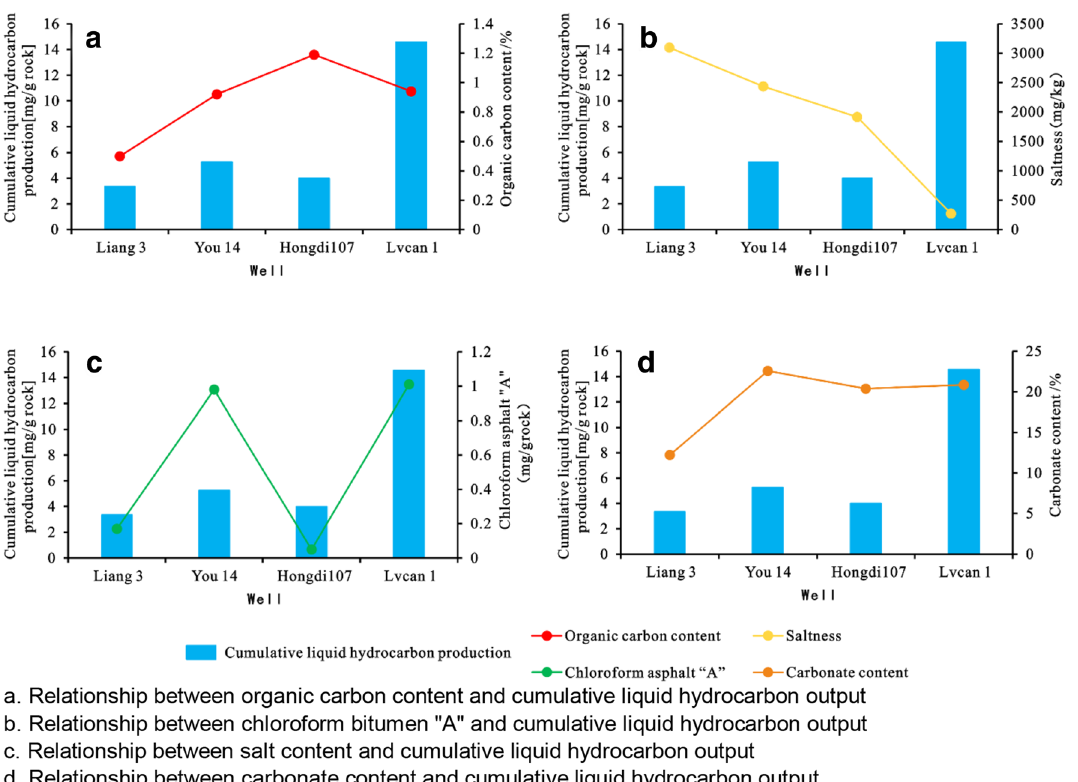
Fig. 4 Thermal simulation of hydrocarbon generation and hydrocar- bon expulsion of Paleogene–Neogene source rocks in the Western Qaidam Basin. a Relationship between organic carbon content and cumulative liquid hydrocarbon output. b Relationship between chlo-